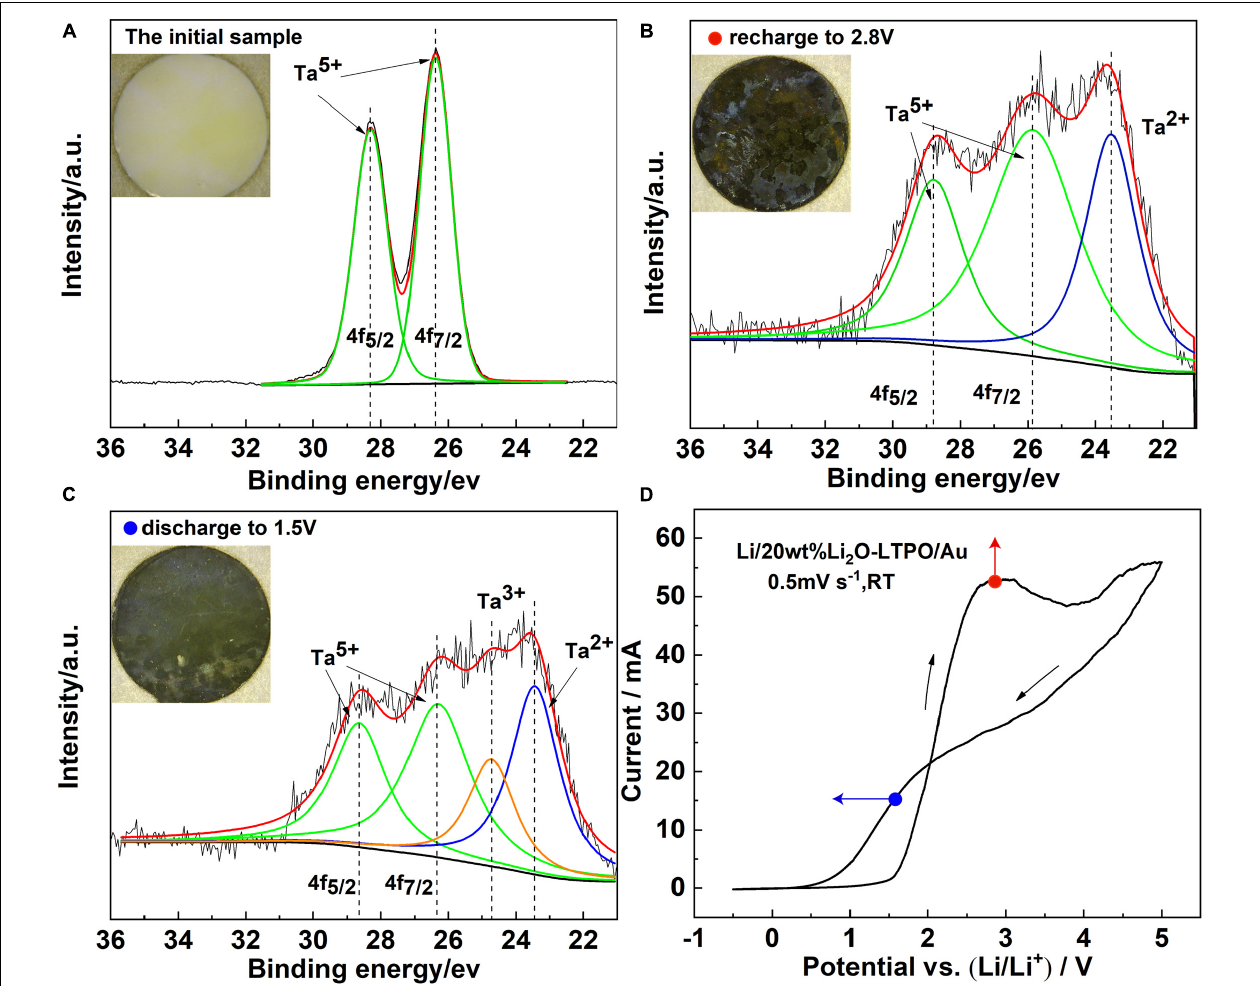
FIGURE 6 | XPS spectra on the surface of LTPO at different potentials correspond to cyclic voltammetry (A) XPS of Ta ion in the initial sample, (B) XPS of Ta ion in the sample at 2.8 V was scanned in the positive direction, (C) XPS of Ta ion in the sample at 1.5 V was scanned in the negative direction, (D) cyclic voltammograms of the LTPO electrode at a scanning rate of 0.5 mV s - 1